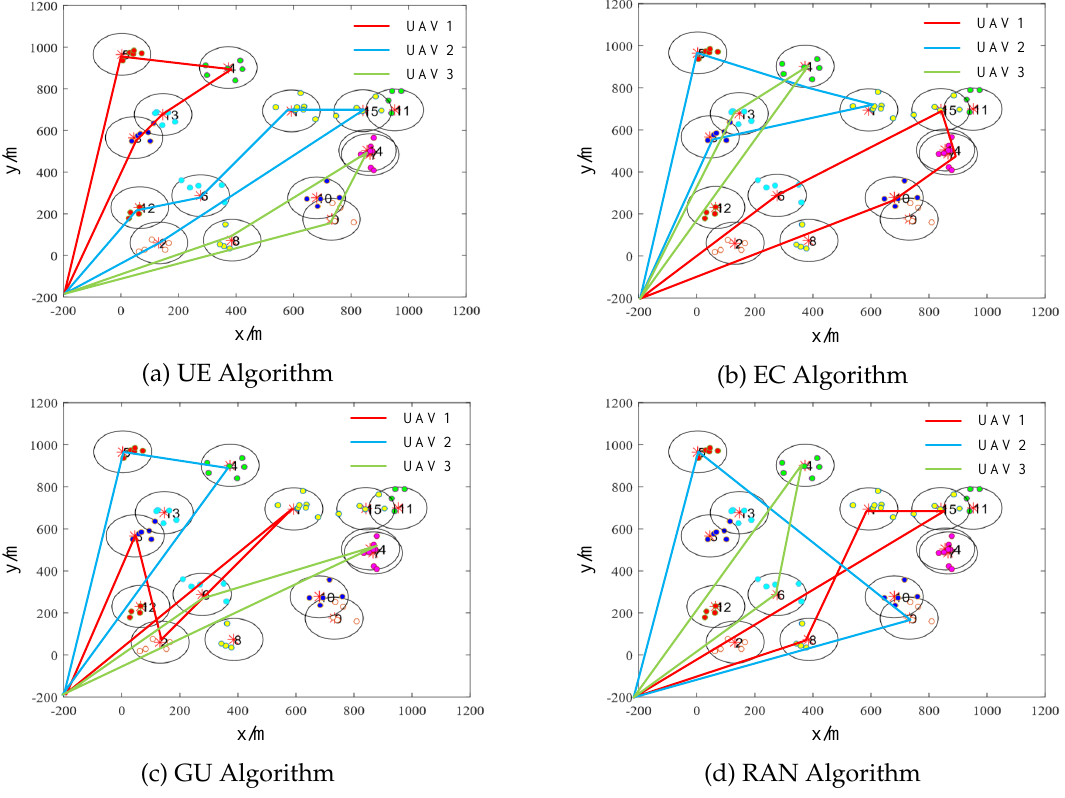
Figure 8. Trajectories of Three